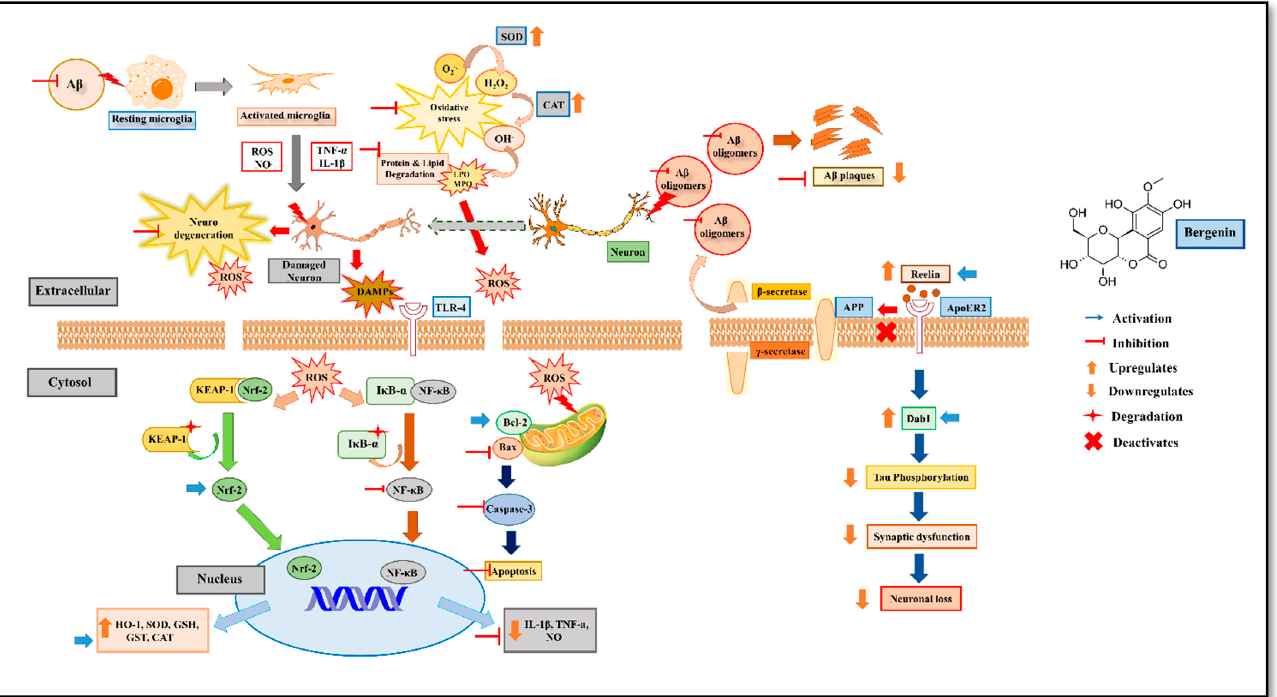
Figure 16. Graphical abstract representing the neuroprotective effect of Bergenin against spatial memory in 5xFAD Tg mice. Amyloid beta (A β ), Amyloid precursor proteins (APP), Apolipoprotein E Receptor 2 (ApoER2), B-cell lymphoma 2 (Bcl-2), Bcl-2 associated X protein (Bax), Catalase (CAT), Disabled-1 adaptor protein (Dab 1), Damage associated molecular patterns (DAMPs), Glutathione (GSH), Glutathione sulfo-transferase (GST), Heme oxygenase (HO-1), Hydrogen peroxide (H 2 O 2 ), Hydroxyl radical (OH-) Interleukin-1 β (IL-1 β ), Kelch-like ECH-associated protein (Keap-1), Lipid peroxidase (LPO), Myeloperoxidase (MPO), Nitric oxide (NO), Nuclear factor kappa B (NF- κ B), Nuclear factor erythroid 2-related factor 2 (Nrf-2), Superoxide radical (O2-.), Reactive oxygen species (ROS), Superoxide dismutase (SOD), Toll-like receptor (TLR-4), and Tumor necrosis factor- α (TNF- α ).